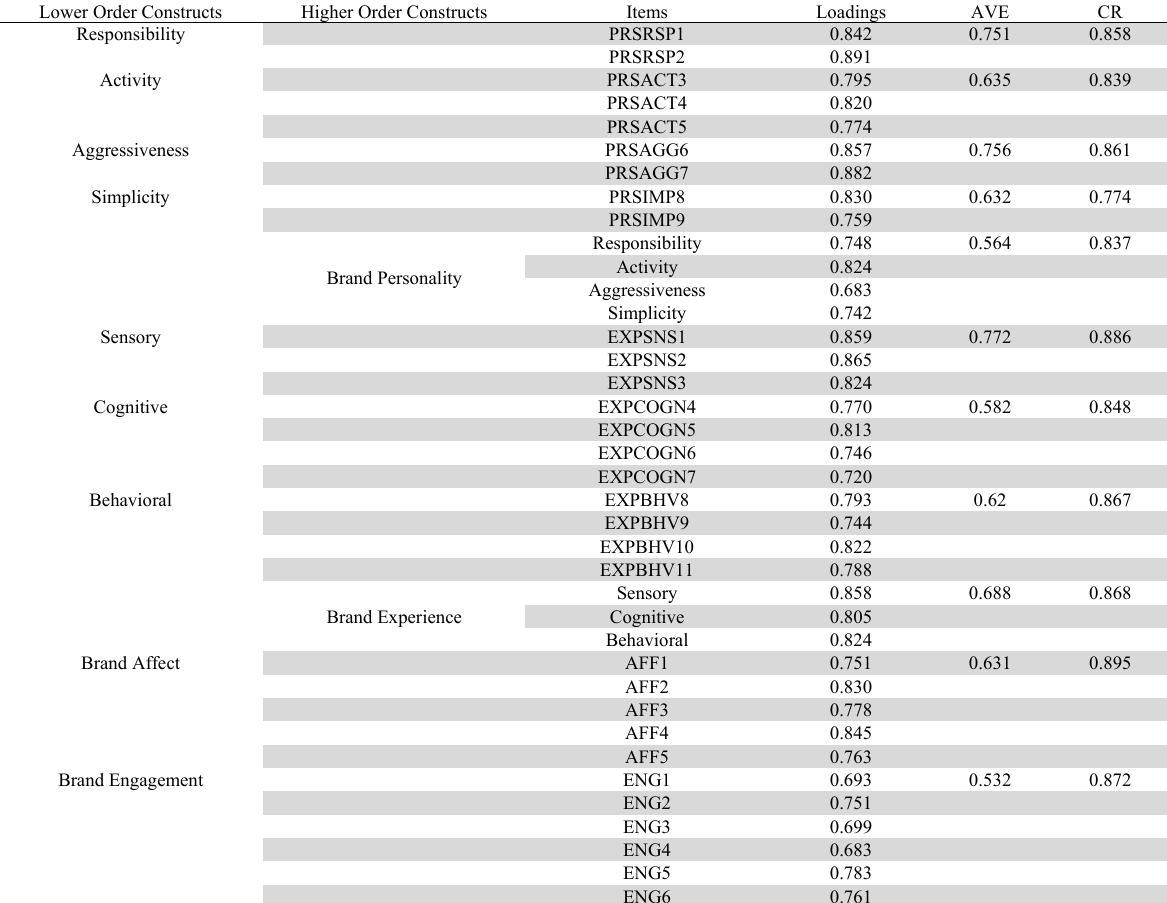
Reliability and Convergent Values - 1st and 2nd Stage Measurement Model Lower Order Constructs